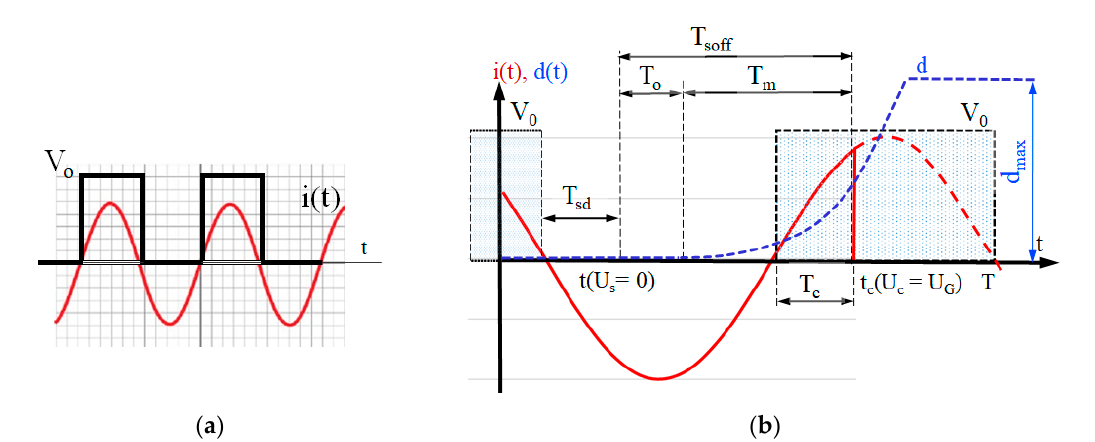
Figure 1. The procedure of realizing contact breaking at the specified moment of the signal waveform: ( a ) synchronization signals ( b ) contacts breaking moment selection; V 0 —“zero” synchronization pulses, t(U s = 0)—supply voltage disconnection moment, T sd —delay of coil supply disconnection, t c (U c = U G )—contacts breaking moment, T c —contacts breaking delay (in relation to waveform “zero”), d—armature movement path, d max —maximum air gap.